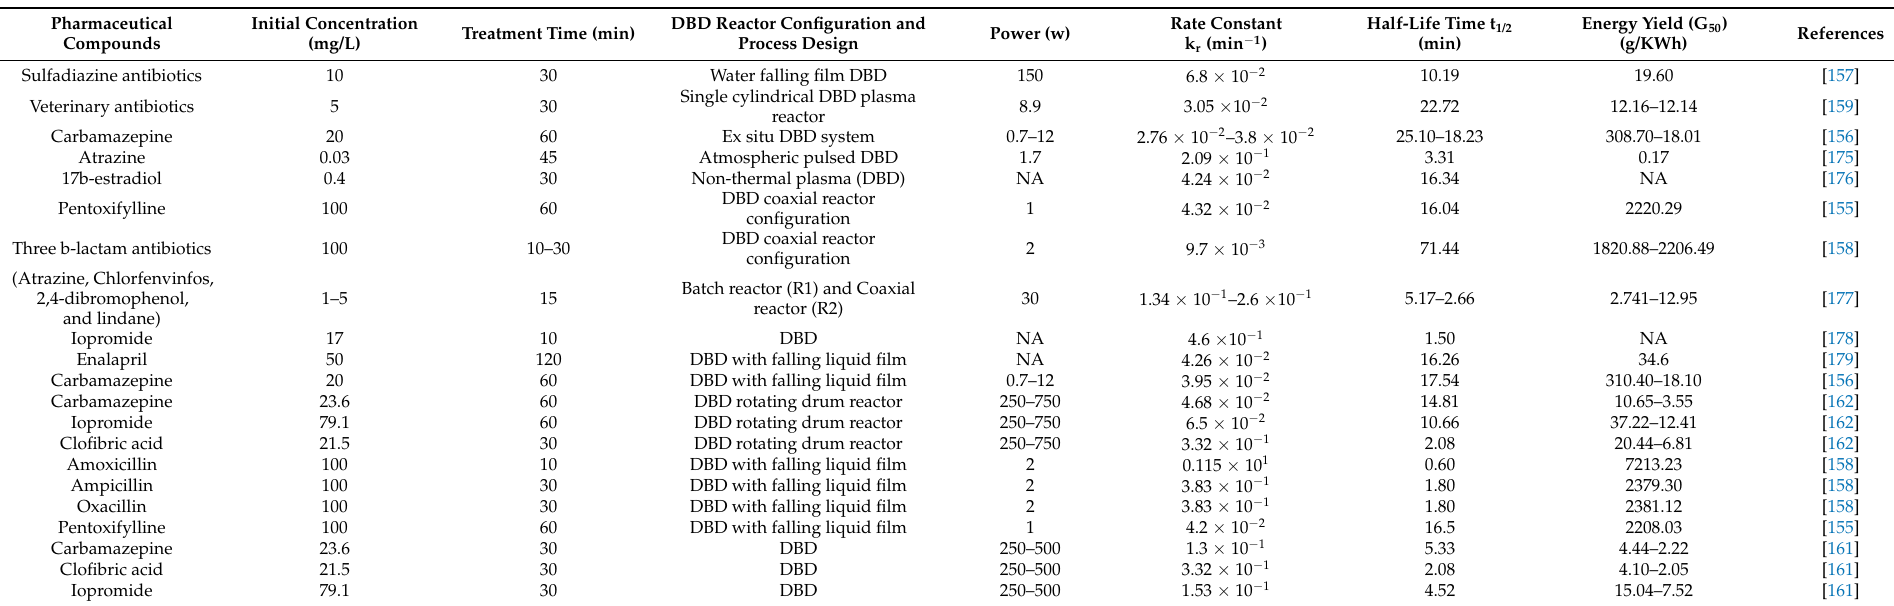
Table 4. Energy yield calculated at 50% degradation of pharmaceutical compounds by various dielectric barrier discharge configurations shown in Table